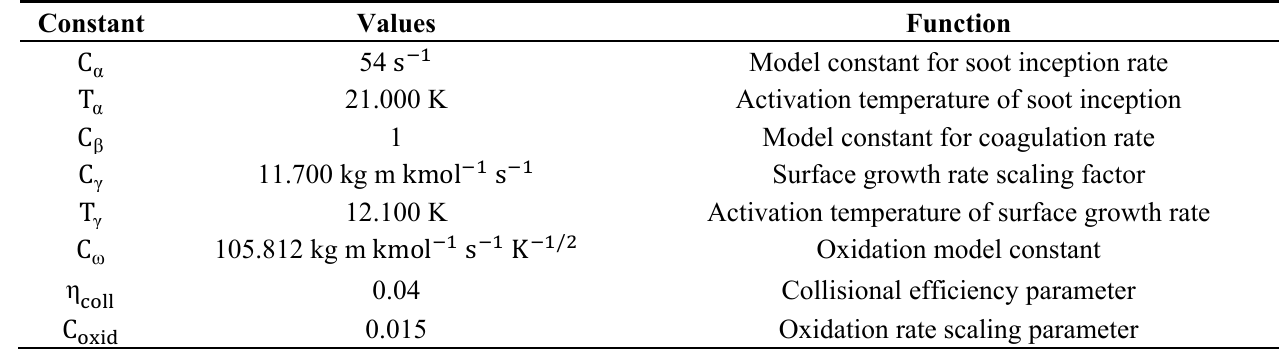
Table 3. Model constant for the soot pollutant emission computing.